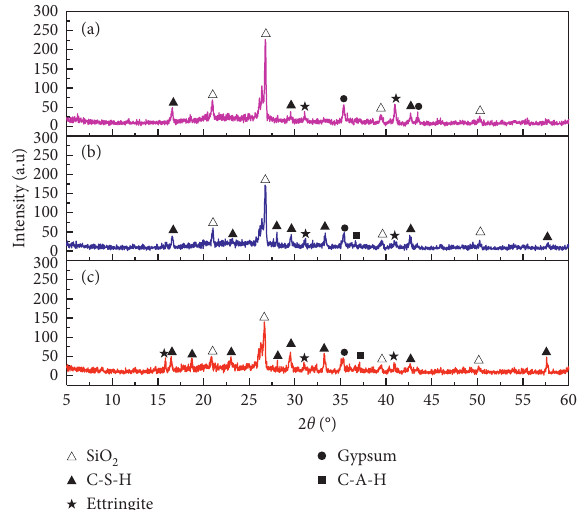
Figure 9: XRD patterns of CPB samples after curing at 80 ° C for 12 hours: (a) RM, (b) PC, and (c)